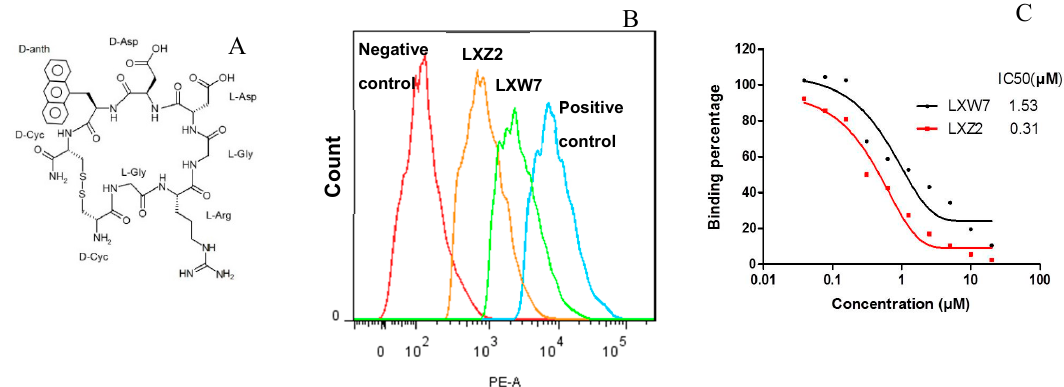
Figure 6. ( A ) Chemical structure of LXZ2; ( B ) Competitive binding assay. 5 µM of LXW7 (green) or